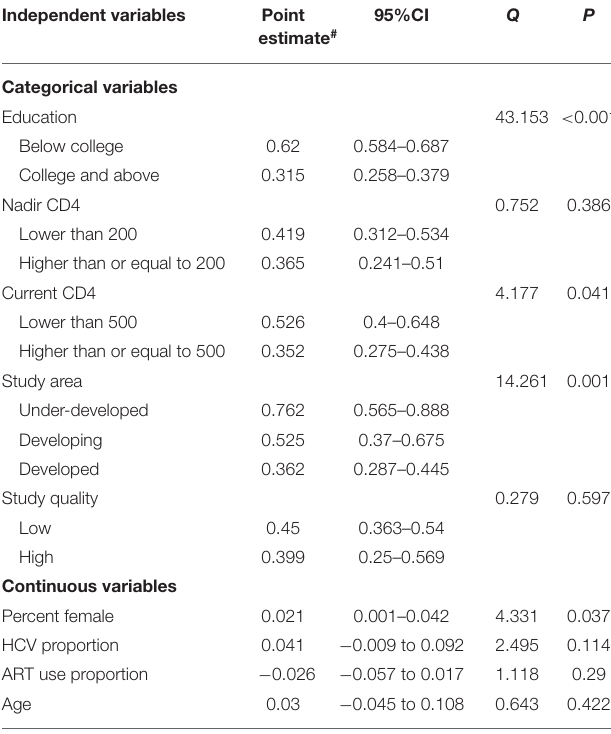
TABLE 2 | Categorical variables associated with